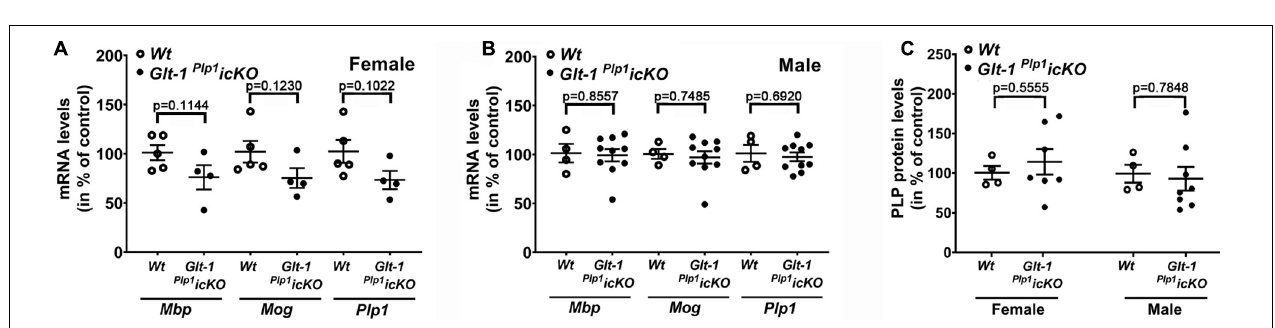
FIGURE 3 | Conditional deletion of Glt-1 from maturing OLGs does not significantly affect myelin gene expression in the corpus callosum of female and male mice. (A,B) Graphs depicting mRNA levels for the myelin genes genes myelin basic protein (Mbp) , myelin oligodendrocyte glycoprotein (Mog) , and proteolipid protein (Plp1) in female (A) and male (B) corpus callosum as determined by reverse transcriptase quantitative polymerase chain reaction (RT-qPCR). (C) Graph depicting PLP protein levels as determined by Western blot analysis. Glt-1 Plp 1 icKO and Wt ( Plp1 CreERT -negative littermate) mice were treated as depicted in Figure 1A and analyzed at 4 weeks of age. Dots represent individual samples (animals), horizontal lines indicate means, error bars are depicted as SEM; individual p -values are depicted for p > 0.05, unpaired t -test (two-tailed).